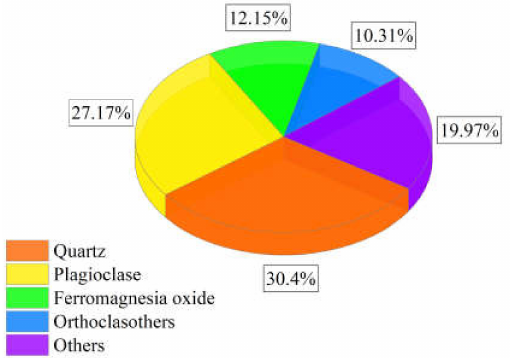
Figure 1. Schematic diagram of the mineral composition of green sandstone.